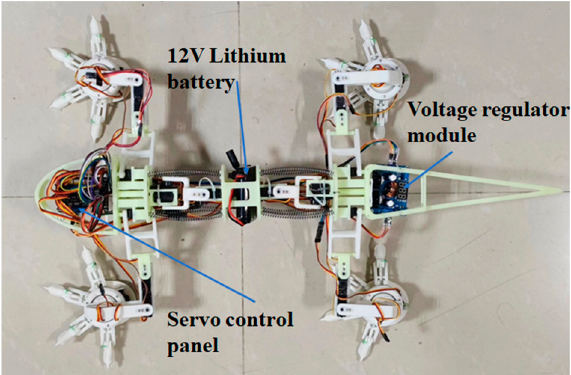
Figure 11. The fabricated prototype of the lizard-inspired quadruped robot.